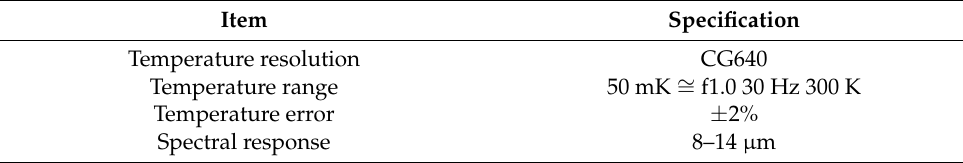
Table 6. Specifications of the thermal-imaging